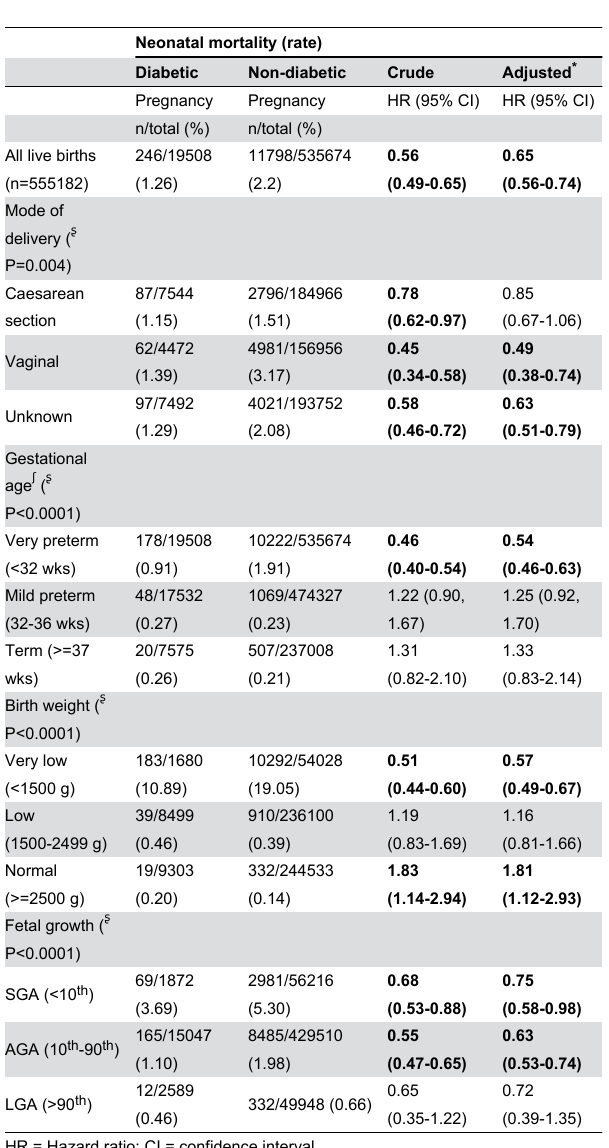
Table 4. Neonatal mortality in diabetic versus non-diabetic twin pregnancies, U.S. matched multiple birth